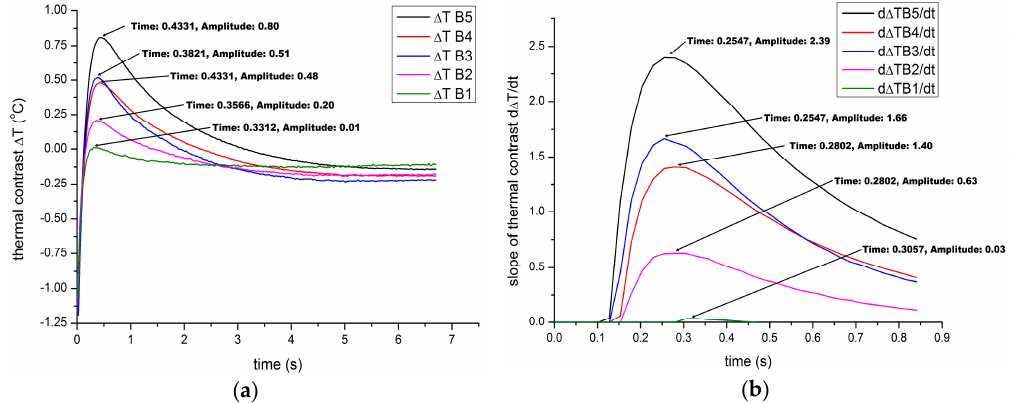
Figure 5. Temporal evolution of: ( a ) the thermal contrast curves; and ( b ) the correspondent slope of the thermal contrasts for the detected insertions on the trapezoid surface located to the depth of 0.4 mm (Series B).